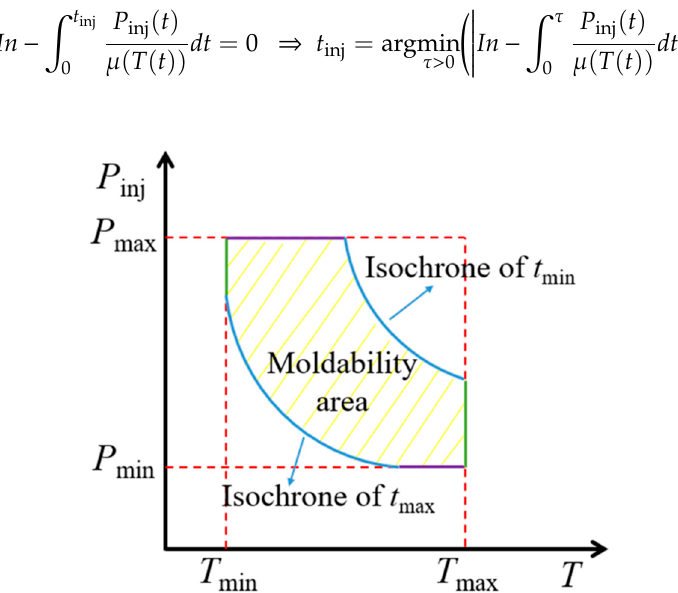
Figure 8. Example of moldability map with constraints on process parameters.